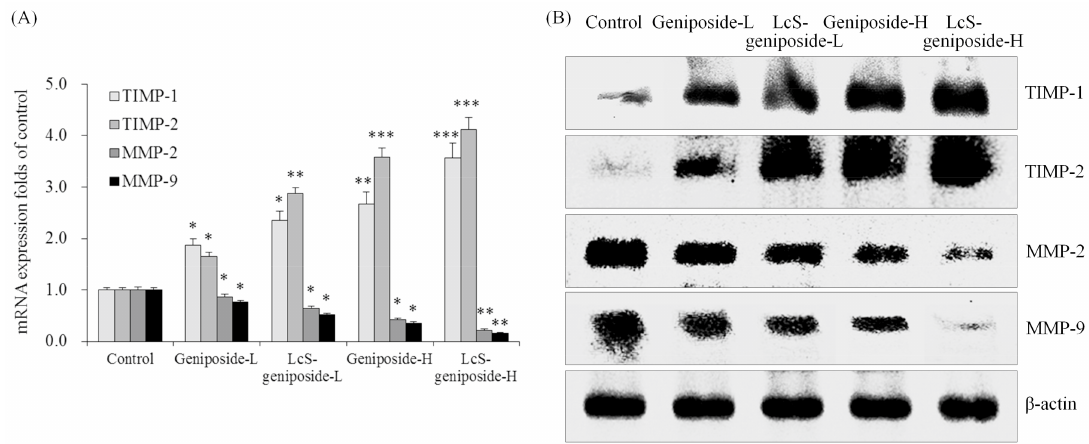
Figure 9. The mRNA ( A ) and protein ( B ) expressions of TIMP-1, TIMP-2, MMP-2 and MMP-9in human oral squamous carcinoma HSC-3 cells. * p < 0.05, ** p < 0.01, *** p < 0.001 vs. the control group. Geniposide-L: 25 µ g/mL geniposide; LcS-geniposide-L: 1.0 × 10 6 CFU/mL LcS + 25 µ g/mL geniposide; Geniposide-H: 50 µ g/mL geniposide; LcS-geniposide-H: 1.0 × 10 6 CFU/mL LcS + 50 µ g/mL geniposide.